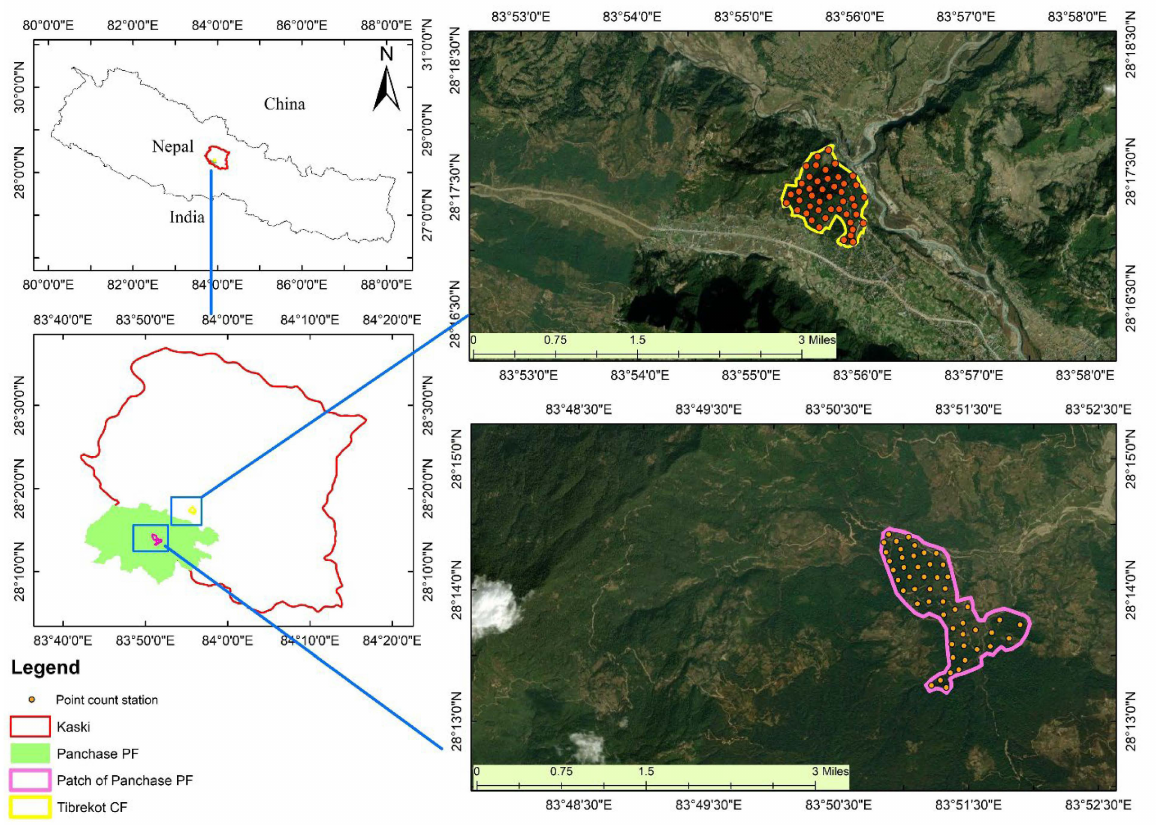
Figure 1. Map of the study area showing point count stations along Panchase Protection Forest (protected forest) and Tibrekot Community Forest (community forest) of Kaski district, Nepal. The protected forest is managed by the government, while the community forest is managed by the community forest users’